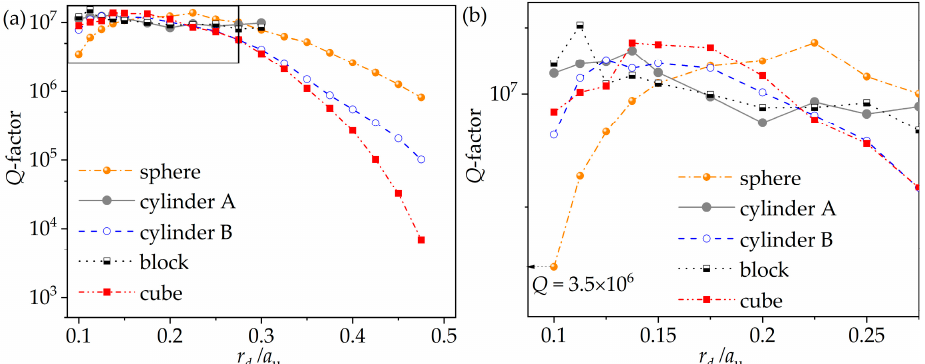
Figure 6. ( a ) Q-factors obtained for the various normalized radii ( r d / a u ) and defect types. ( b ) Zoom-in of the highlighted region in ( a ).